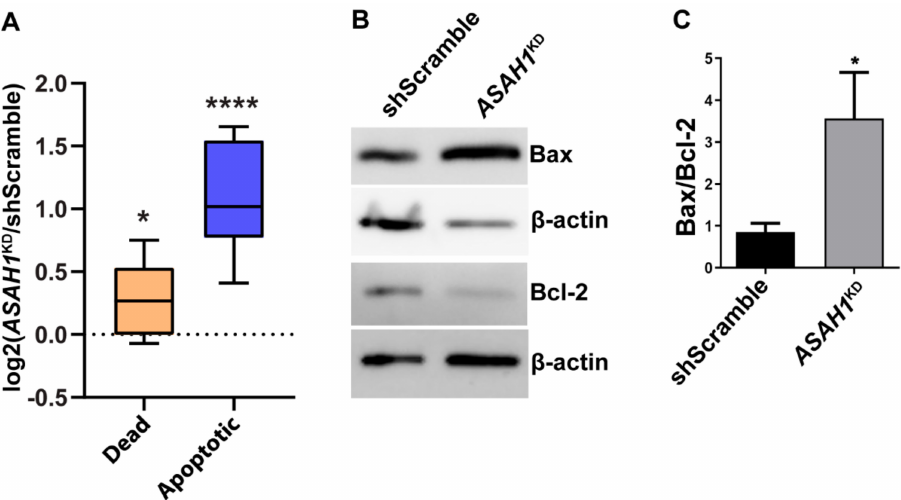
Figure4. ACdepletioninducesapoptosisin ASAH1 KD cells. ( A )Box-and-whiskerdiagramofindividual log2-transformed percentage ratios of ASAH1 KD cells to shScramble for cell death and apoptosis, respectively. Data points above 0 indicate a percentage increase for ASAH1 KD cells. **** p = 0.002 for apoptosis and * p = 0.0264 for cell death ( n = 9, one-sample t-test with multiple testing correction). ( B ) Representative Western blot results showing an increase of pro-apoptotic marker Bax and a decrease of anti-apoptotic marker Bcl-2 in ASAH1 KD cells. β -actin was used as loading control. ( C ) Ratio